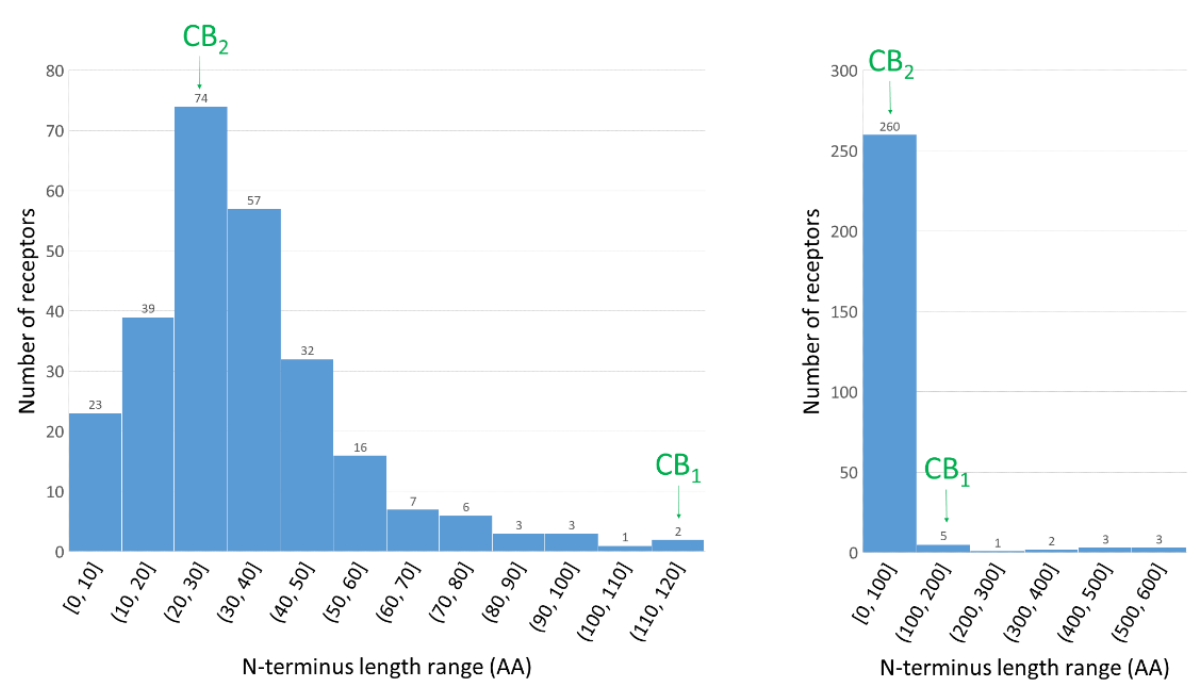
Figure 4. Distribution of N-terminus lengths within class A of GPCRs. On left the histogram with 10 amino acid interval; on right the histogram for all class A GPCR, without odorant receptors, with 100 amino acid interval. Number of receptors in each range is specified above each bar. The ranges are given in parenthesis which are open from left side. Based on GPCRdb data [33].